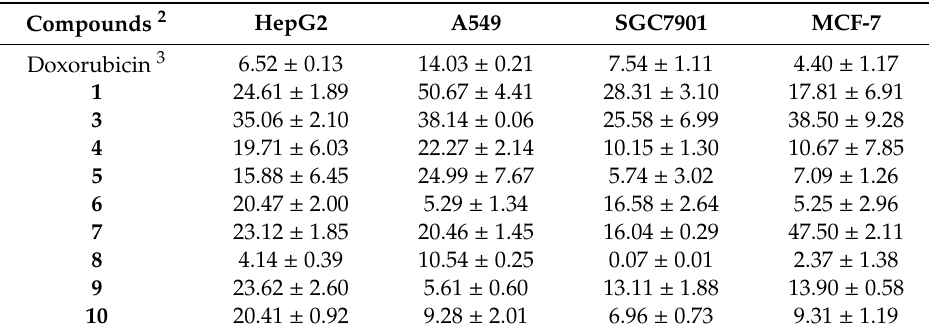
Table 2. Anti-proliferation activity of isolated xanthones 1